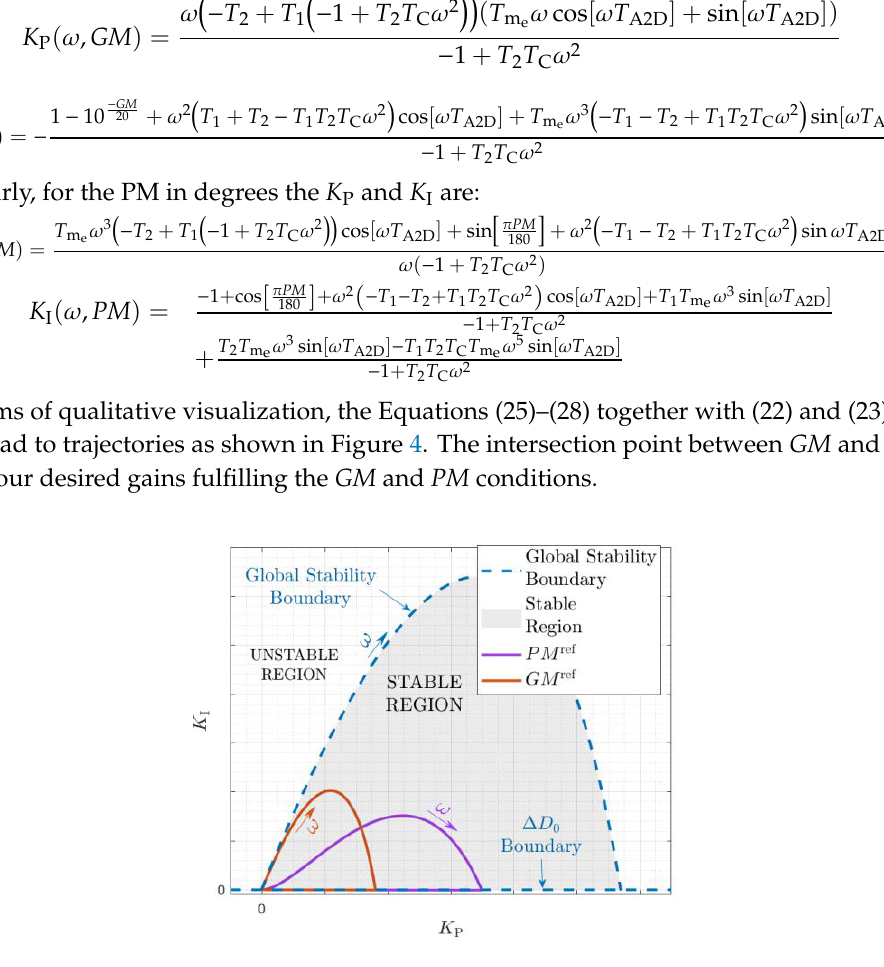
Figure 4. Qualitative visualization of the global stability boundary together with the boundaries for the desired PM and GM for control structure shown in Figure 2. The intersection of the PM and GM lines stands for the requested dynamics.